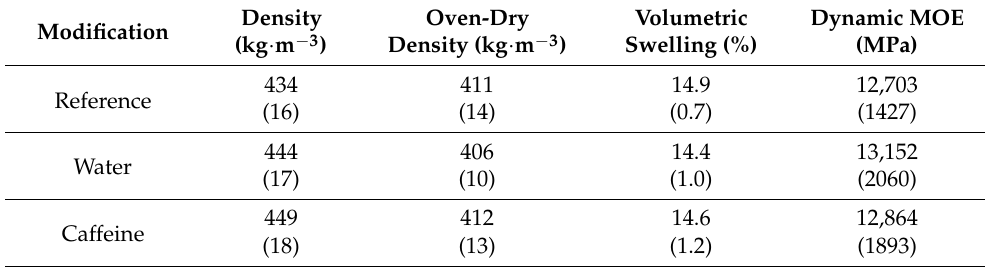
Figure 4. Static modulus of elasticity and modulus of rupture. Table 1. Basic statistical analyses, mean value (standard deviation) of the selected properties for spruce